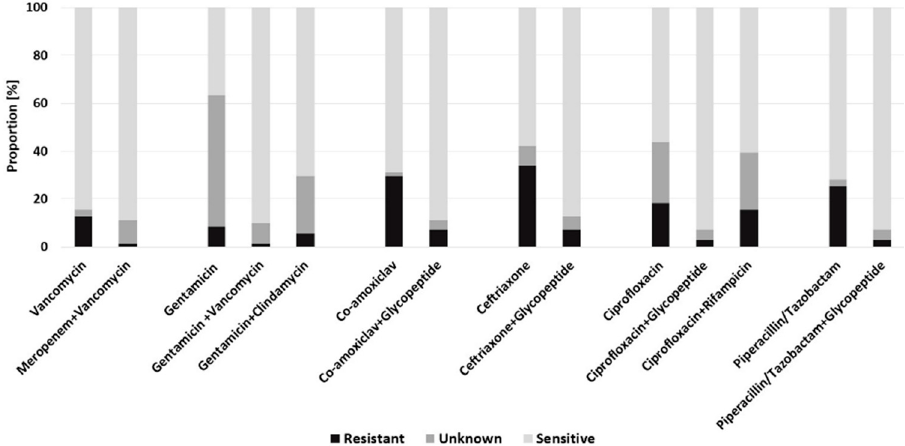
Figure 2. Predicted efficacy of empiric antimicrobial regimens for the PJI cohort.